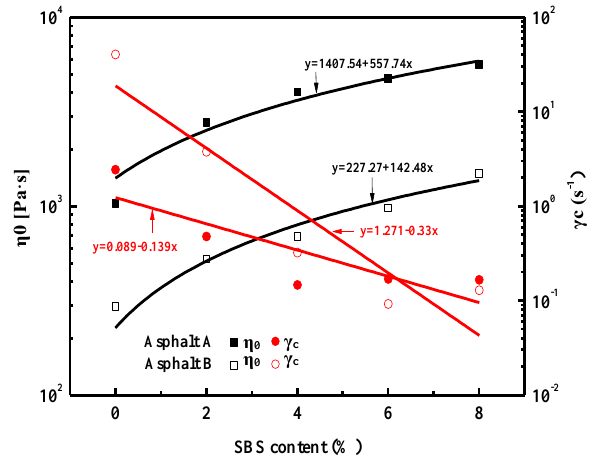
Figure 7. E ff ects of SBS latex content on the Carreau model parameters of modified Figure 7. Effects of SBS latex content on the Carreau model parameters of modified asphalts.